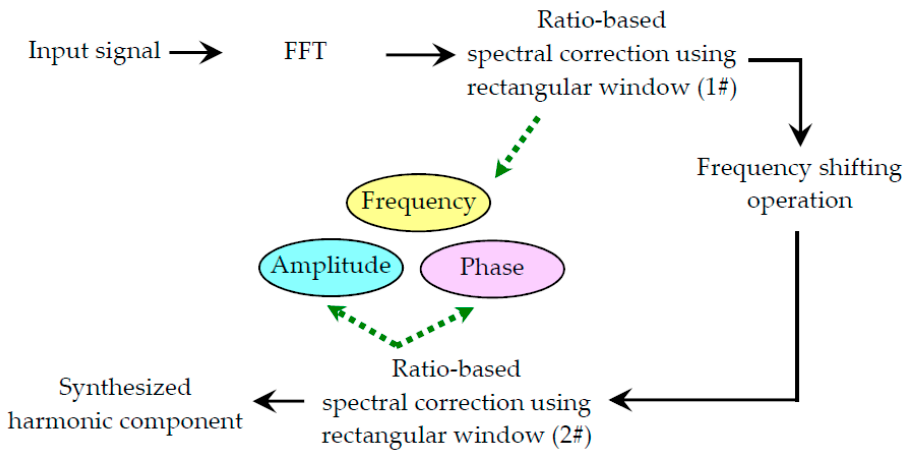
Figure 8. The interpolated spectral bins around an actual harmonic component.